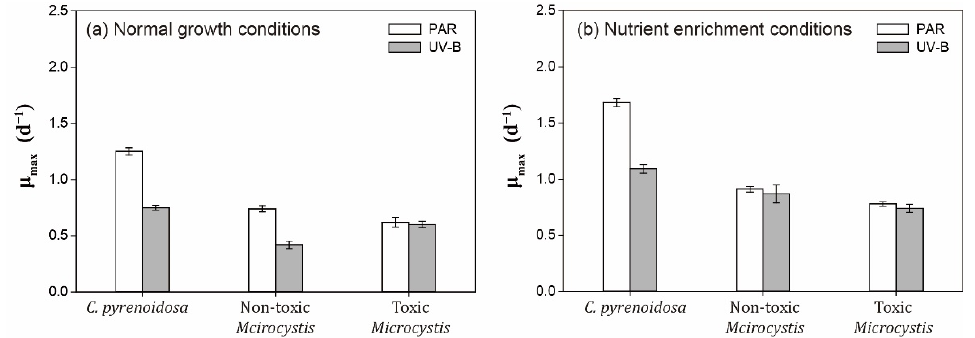
Figure 2. Maximum growth rates of three species in the PAR and UV ‐ B treatment under normal growth conditions and nutrient enrichment conditions.